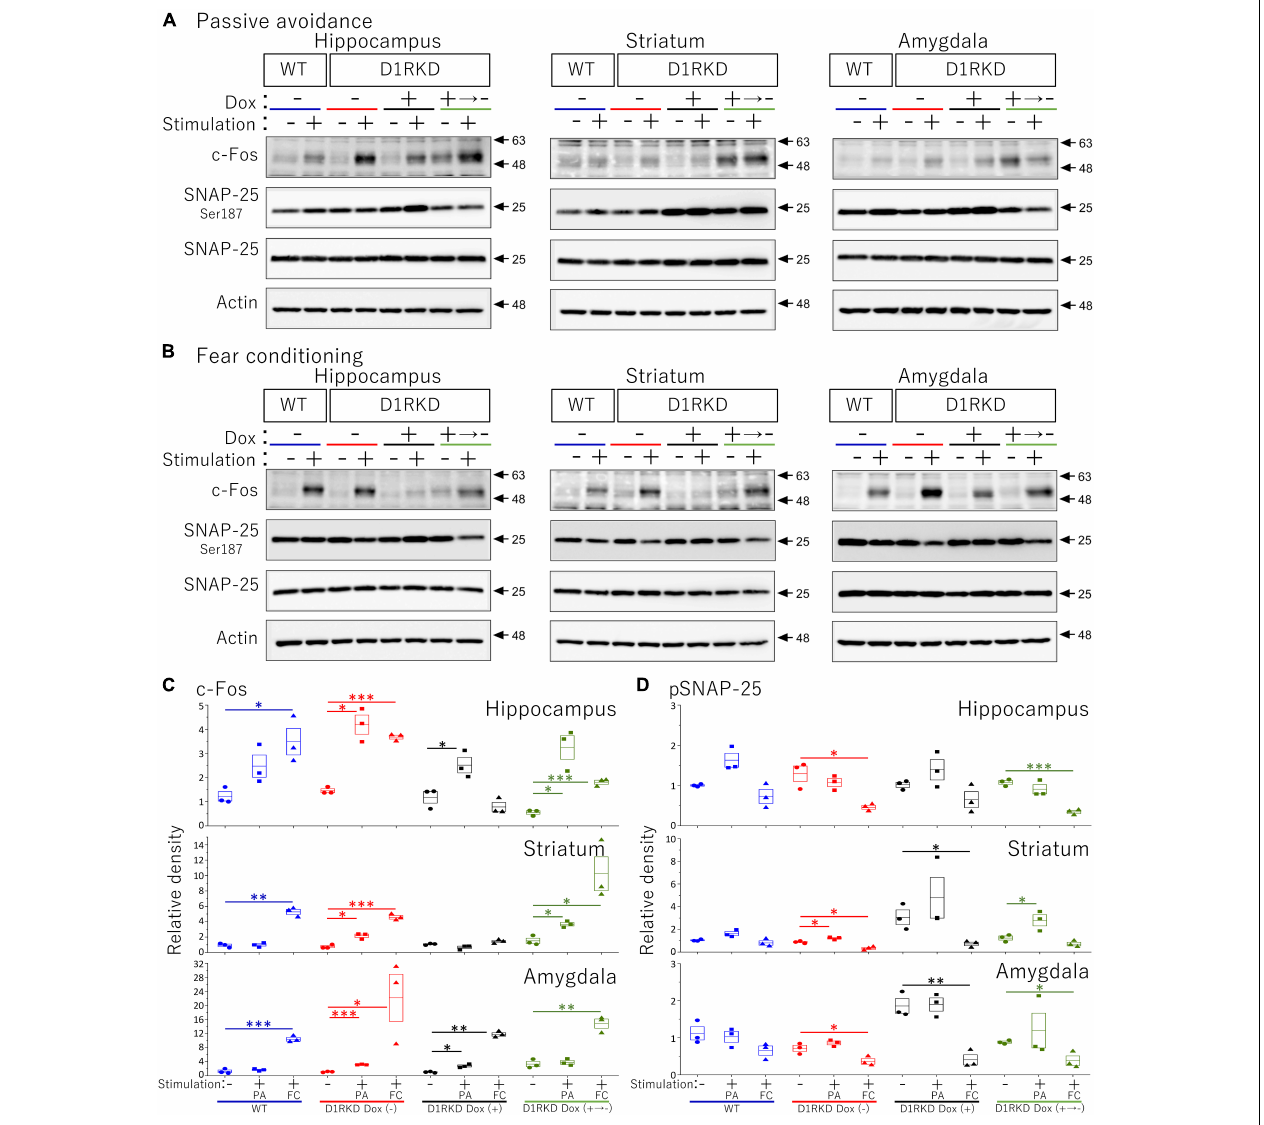
FIGURE 8 | Immunoblot analysis of c-Fos, SNAP-25 phosphorylation at Ser187, SNAP-25, and Actin expression in homogenates from the hippocampus, striatum, and amygdala after 1 h of electric footshock stimulus using a step-through-type apparatus for the passive avoidance test (PA) or fear conditioning system (FC). (A) Representative immunoblot images using the apparatus for PA. (B) Representative immunoblot images using the system for FC. Samples without electric footshock stimulus were used as controls. Actin was used as a loading control. (C) The relative band intensities of c-Fos. (D) The relative band intensities of SNAP-25 phosphorylation at Ser187. These band intensities were represented as the ratio of WT mice without stimulation as control of two type stimulation, separately. Actin was used as a loading control. Data shown are from three independent experiments. The blue color indicates the values of WT groups, the red color indicates the values of D1RKD Dox (–) groups, the black color indicates the values of D1RKD Dox (+) groups, and the green color indicates the values of D1RKD Dox (+ → –). The circle, square, and triangle indicate no stimulation, stimulation by PA, and stimulation by FC, respectively. All groups, n = 3, ∗ p < 0.05; ∗∗ p < 0.01; ∗∗∗ p <